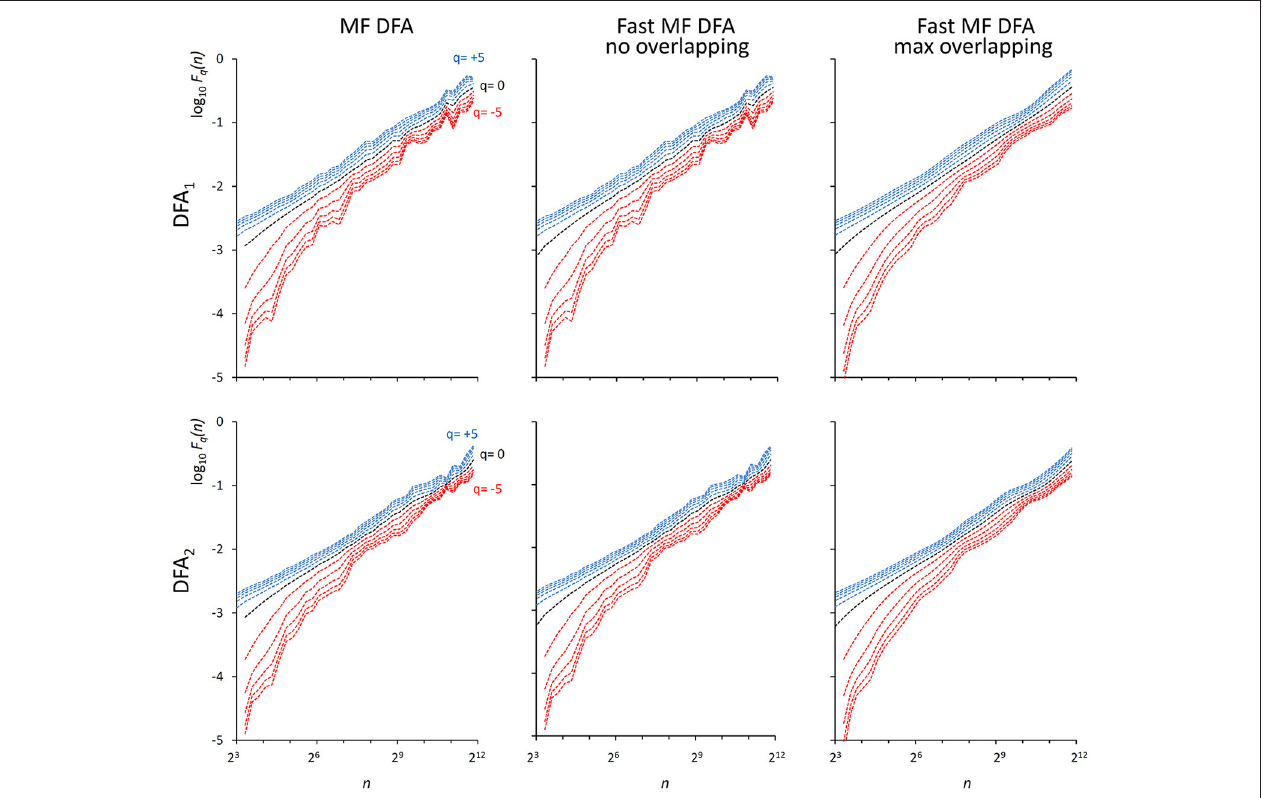
FIGURE 3 | F q (n) functions for a multifractal binomial cascade embedded in noise of N = 65,536 samples . Estimates without overlapping by the traditional (Left) and fast (Center) algorithm and with maximum overlapping by the fast algorithm (Right) were performed over 38 block sizes, with thresholds as in Equations (19) and EPS = 0. On a laptop computer, the traditional algorithm employed T = 4.3s for DFA 1 and T = 9.5s for DFA 2 without overlapping while the fast algorithm employed 0.12s without overlapping and 3.6s with maximum overlapping for calculating DFA 1 and DFA 2 estimates simultaneously.